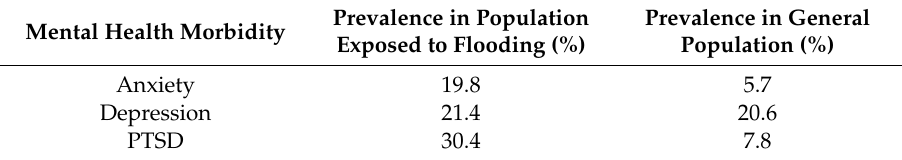
Table 2. Mental health morbidity prevalence for population exposed to flooding and general population for anxiety, depression and post-traumatic stress disorder